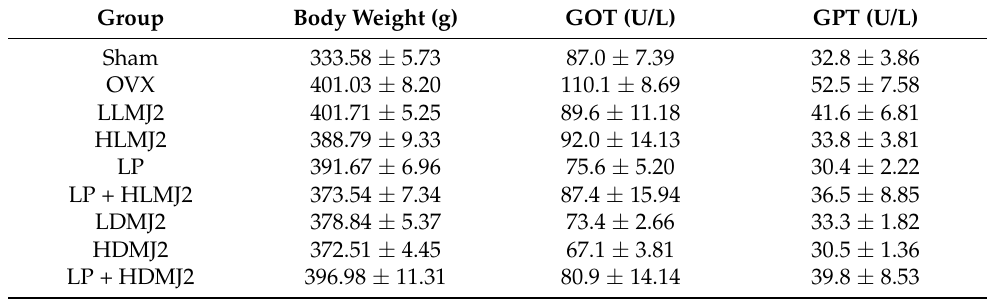
Values indicate the mean ± SEM.